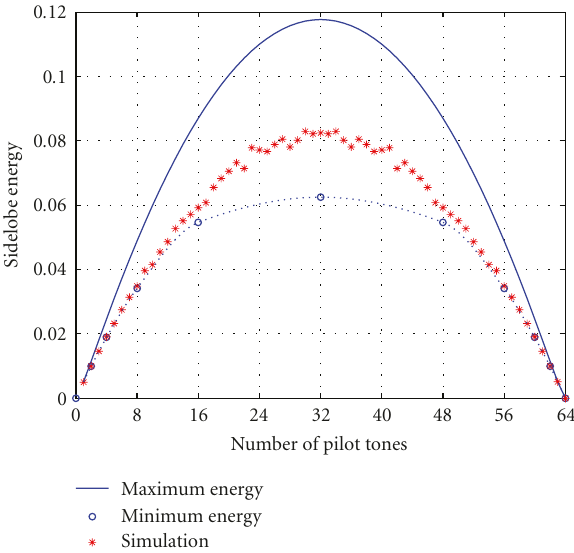
Figure 7: Aperiodic ACF sidelobe energy values of the waveforms whose sidelobe peaks are minimized. Minimum and maximum energy values are shown. (Minimum energy values for pilot num- bers for which N/P is not an integer are obtained by interpolation and plotted with dashed lines.)